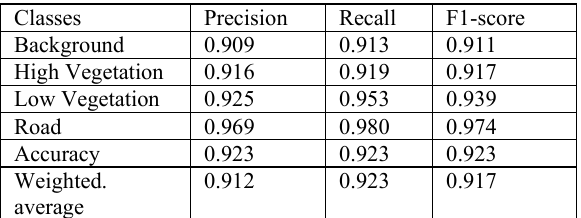
Figure 7: Confusion matrix showing the accuracy rate for two classes: tree trunk (l) and poles (p)